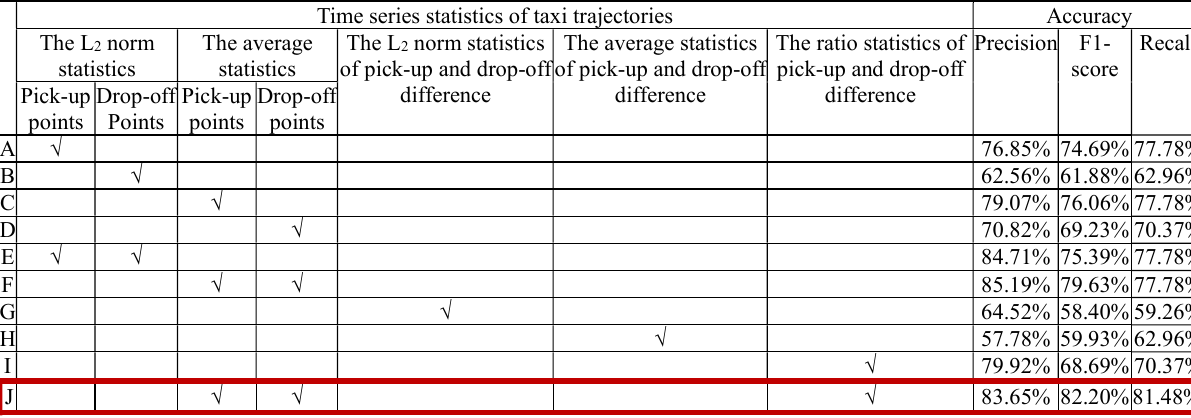
Table 1. Identification accuracy results of urban functional districts with different combinations of time series statistics (Zhang,